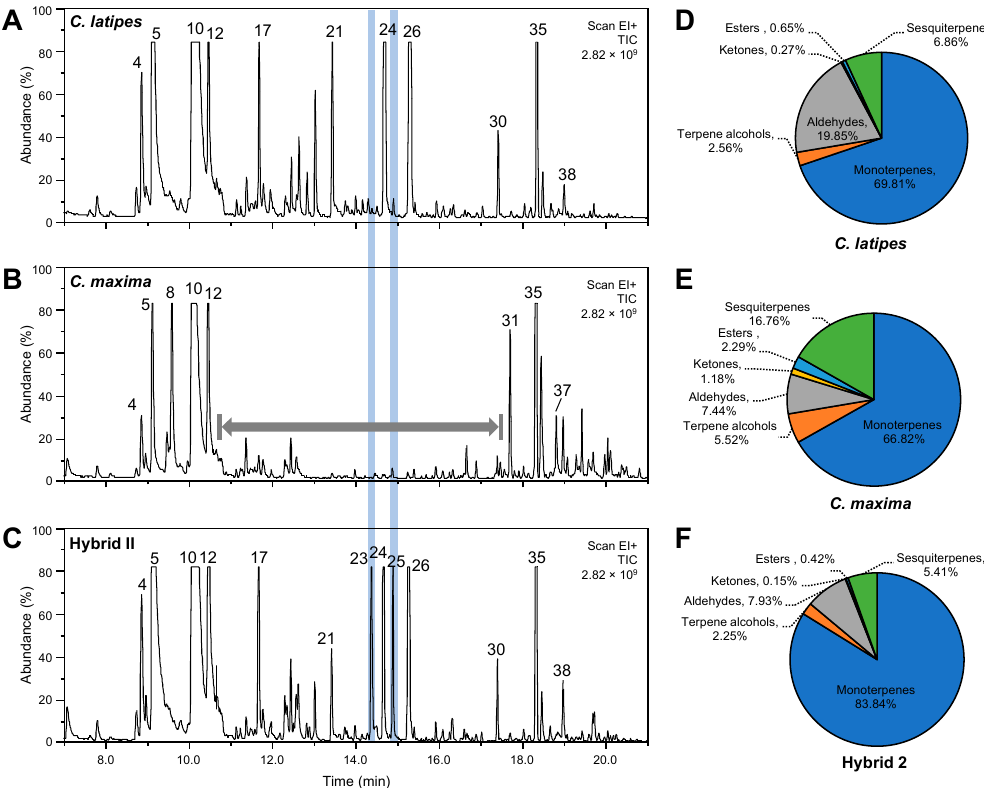
Figure 4. Released volatile organic compounds detected via solid phase microextraction (SPME) in Citrus maxima , C. latipes and their promising sexual hybrid (Hybrid II). ( A – C ) GC-MS representative chromatograms of the volatile organic compounds released from the leaves of C. latipes and C. maxima and their promising hybrid (Hybrid II). ( D – F ) Percentages of different volatile groups released from C. maxima, C. latipes and their promising hybrid (Hybrid II). The peak numbers on the representative SPME chromatograms correspond to Table 2. The vertical blue bars refer to peak 23 and peak 25. The gray horizontal bar in C. latipes chromatogram ( C ) indicates the interval (11–18 min) where most of the differences in released volatiles were observed.